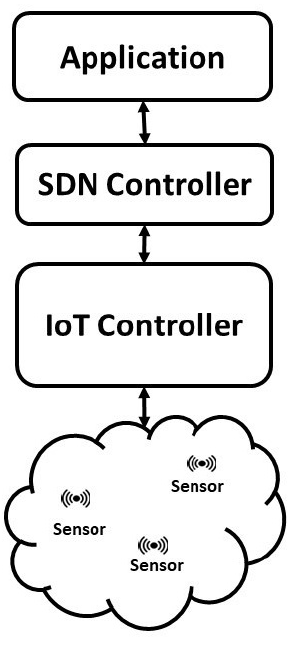
Figure 1. SDN based managed IoT